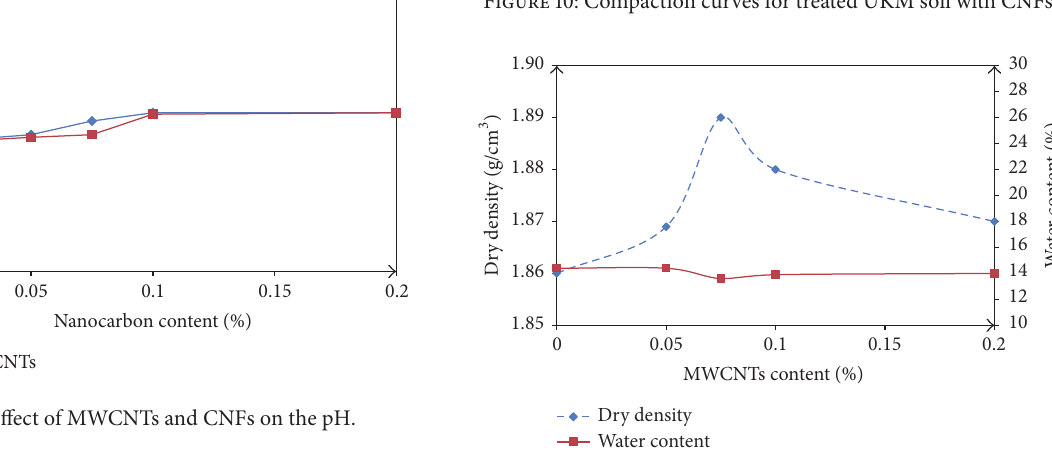
Figure 10: Compaction curves for treated UKM soil with CNFs.